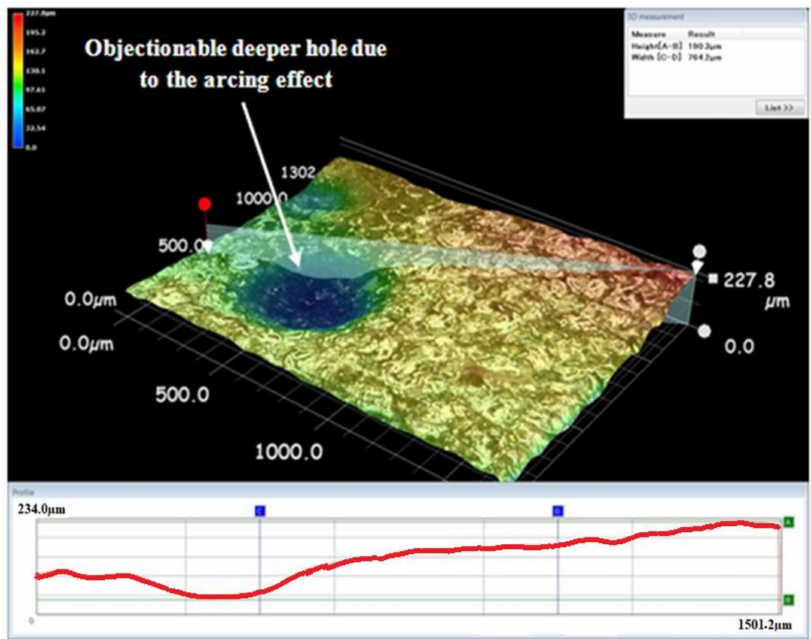
Figure 7. Surface morphology of the machined specimens under arcing.